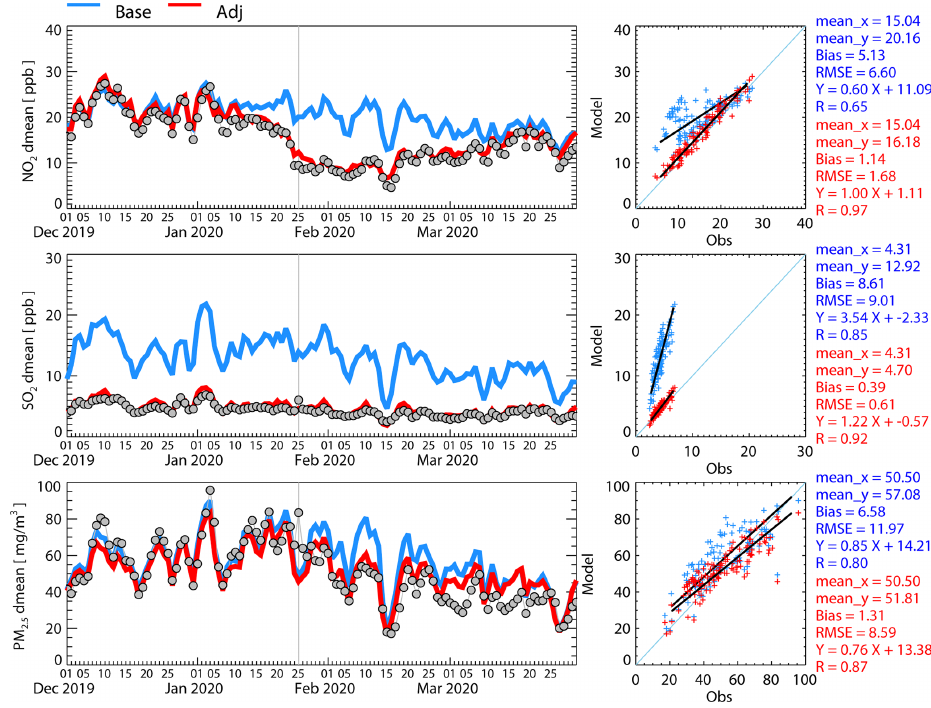
Figure 4. Time series and scatterplots of observed and modeled surface concentrations of SO 2 , NO 2 , and PM 2 . 5 from 1332 Chinese surface- monitoring sites during the pandemic period. Model simulations using the baseline emission inventory (CREATE) and top–down adjusted emissions are shown in blue and red, respectively. Observations are represented by gray circles.